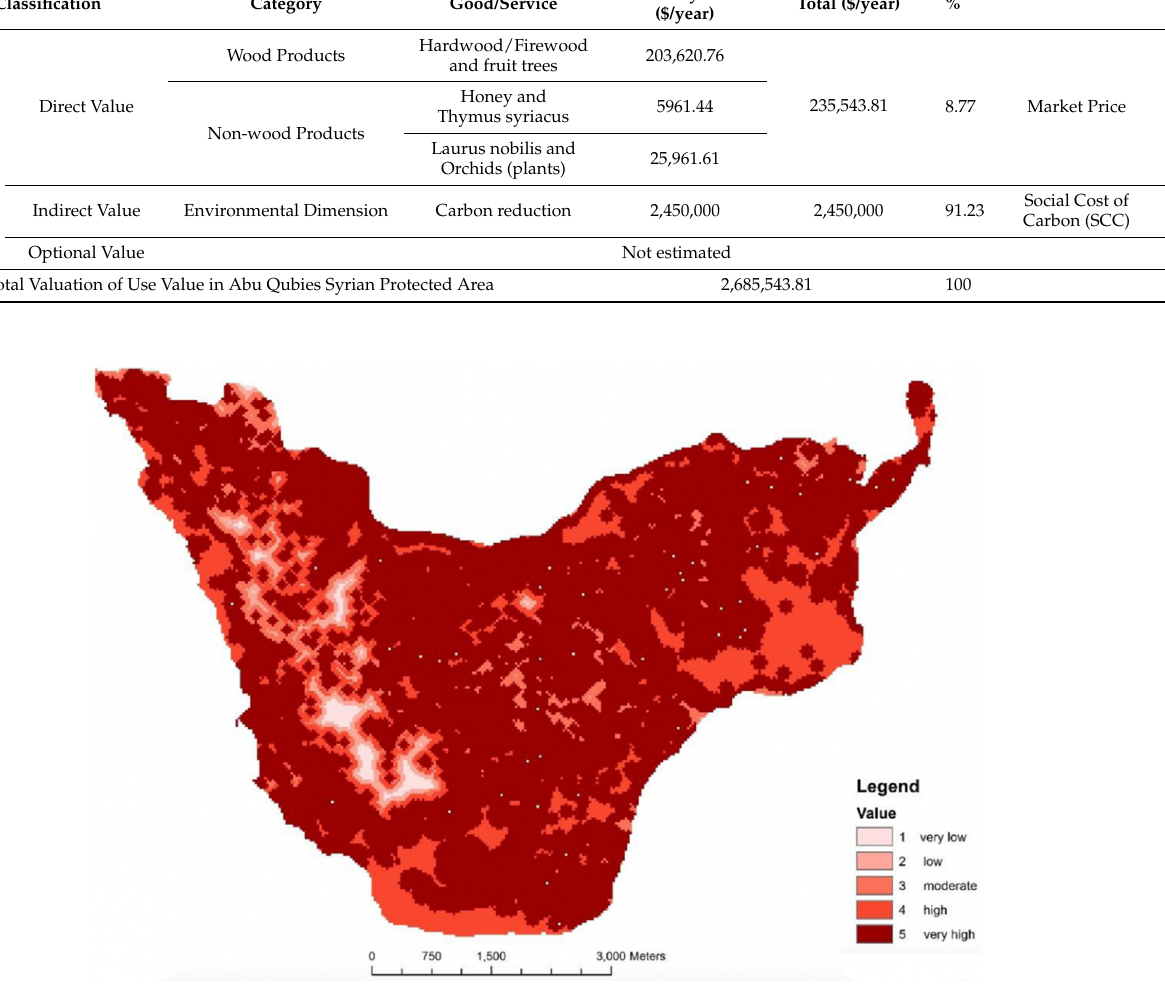
Figure 6. Graded color map representing Abu Qubies’ use values (direct and indirect). Table 1. Monetary values of ecosystem use value in Abu Qubies protected area.